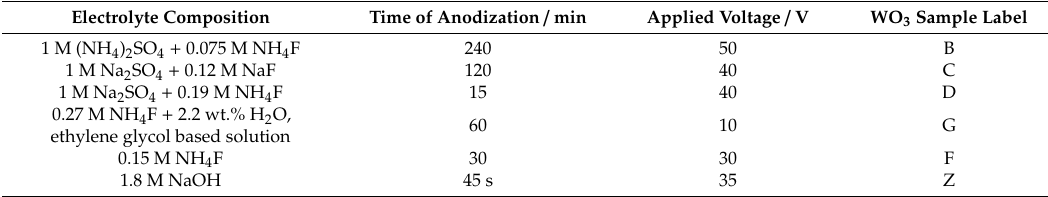
Table 4. Operating Conditions of Anodic Oxidation of Tungsten